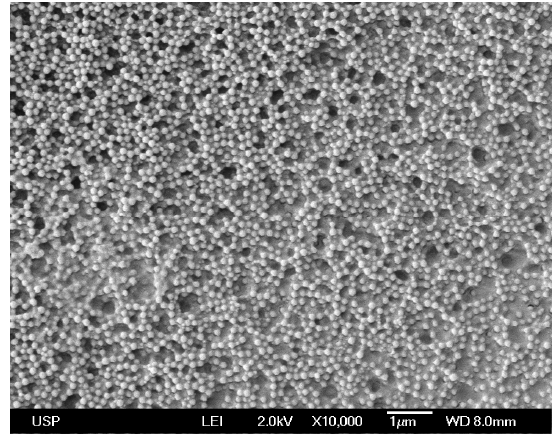
Figure 1. Scanning electron micrograph of the poly(methylmethacrylate) (PMMA)/poly(diallyldimethyl ammonium) chloride (PDDA) coating obtained by casting 0.050 mL of the original A4 nanoparticles dispersion (10 mg/mL) onto silicon wafers.